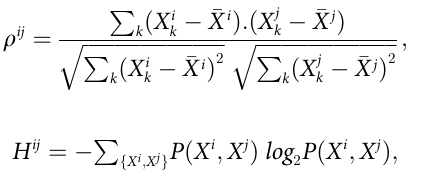
ffiffiffiffiffiffiffiffiffiffiffiffiffiffiffiffiffiffiffiffiffiffiffiffiffiffiffi